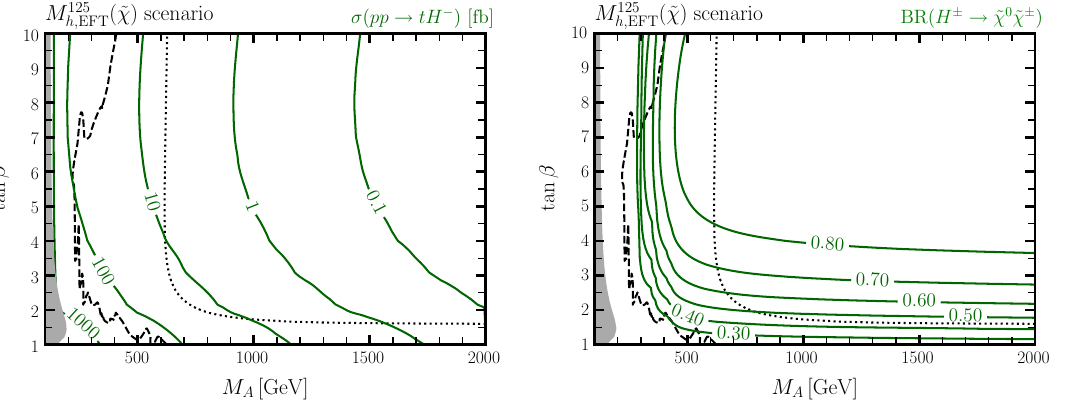
( ˜ χ) sce- ( green contour lines ). The contributions from all kinematically allowed h , EFT combinations of electroweakinos in the final state are summed. In each plot, the gray exclusion region and the boundaries of the blue and the hatched exclusion regions (shown as dashed and dotted black lines , respectively) of Fig.4 are also depicted